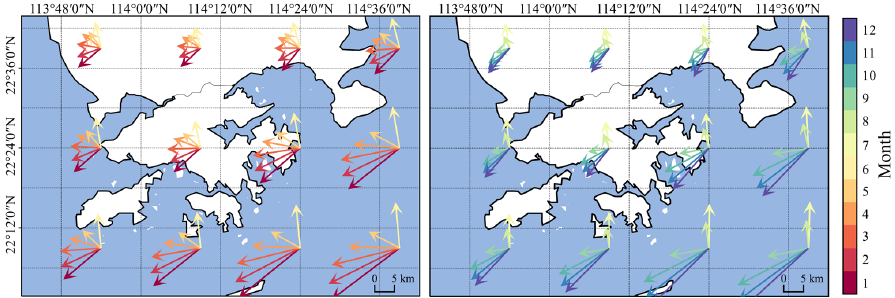
Figure 10. The monthly average direction and intensity of winds from 1986 to 2021. Arrows represent wind directions. The lengths of the arrows represent the wind speed.